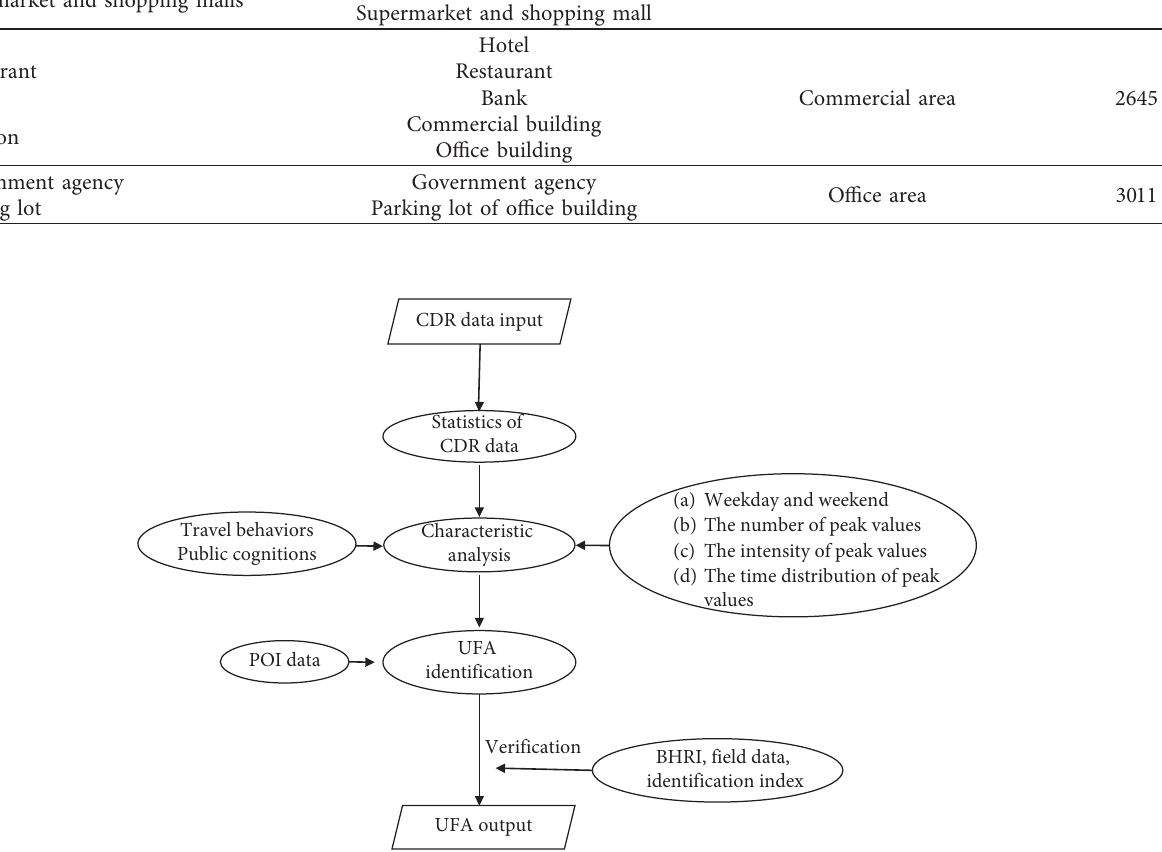
Figure 2: Flowchart of identification.